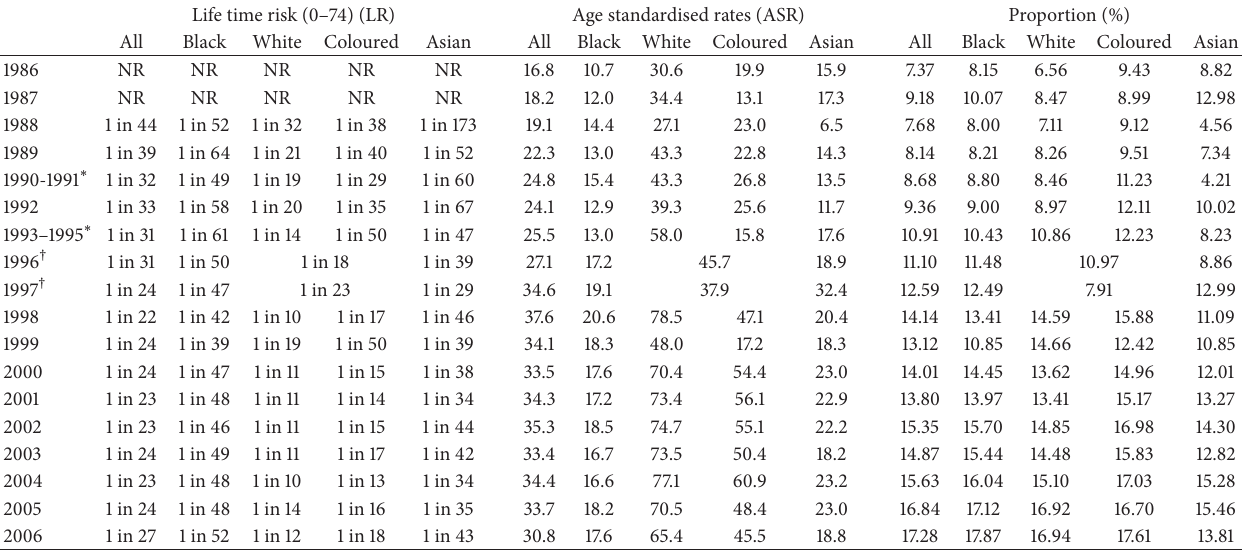
Table 2: South African pathology based National Cancer Registry summary statistics for prostate cancer years 1986–2005 by population